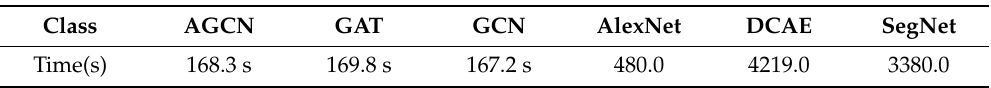
Table9. Comparisonoftheruntime(seconds)withfivestate-of-the-artalgorithmsontheFangchenggangdataset.